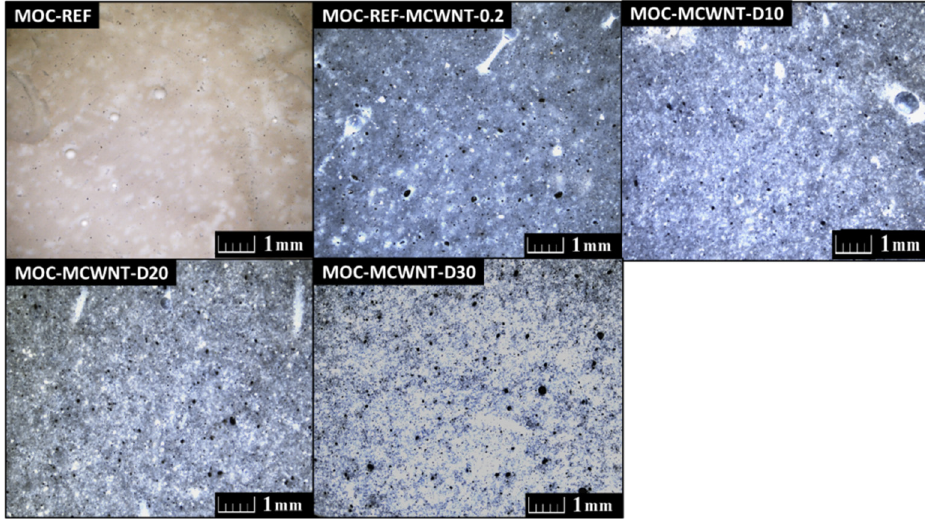
Figure 2. The photograph of the prepared composites obtained from OM .